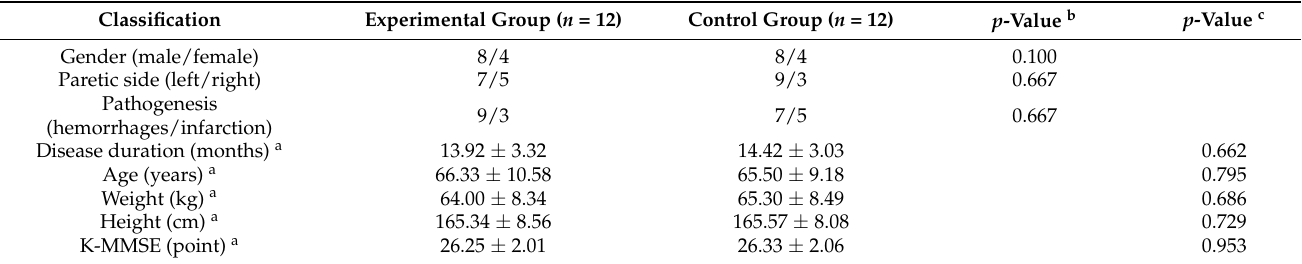
Table 1. Subject characteristics.